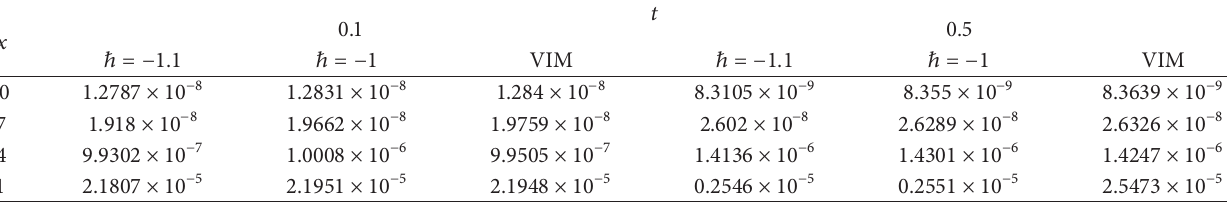
Table 1: Absolute errors of 𝑢(𝑥, 𝑦,𝑡) .